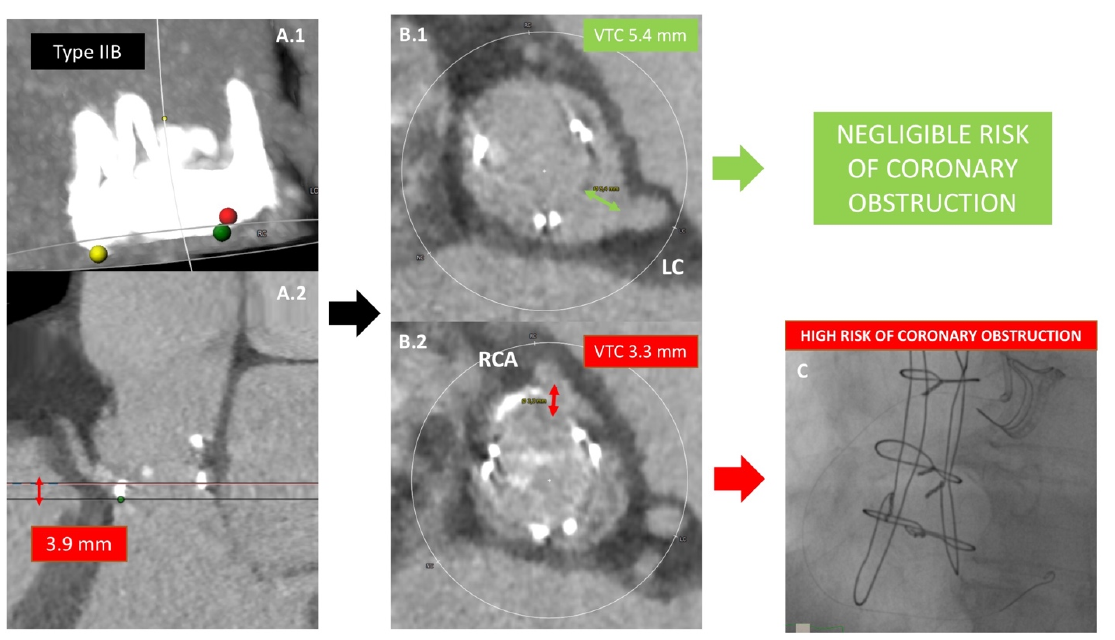
Figure 4. Prediction of coronary artery obstruction . A 60-year-old lady presented with Carpentier- Edwards Perimount BHV degeneration. The BHV frame extends above the coronary ostia, but below the sinotubular junction ( A.1 , A.2 ), showing RCA distance from the annulus of 3.9 mm). This situation is potentially at increased coronary obstruction risk. In this case, the following step is to calculate the VTC distance, intended as the distance between the prosthetic frame and coronary ostia: for the LCA the VTC is 5.4 mm ( B.1 ) whereas a shorter VTC is depicted for the RCA ( B.2 ). Considering a cut-off value of 4 mm, the patient is judged at negligible risk of LCA occlusion during ViV TAVR but at increased risk for RCA occlusion. For this reason, prophylactic RCA wiring and stenting are performed during ViV TAVR ( C ).